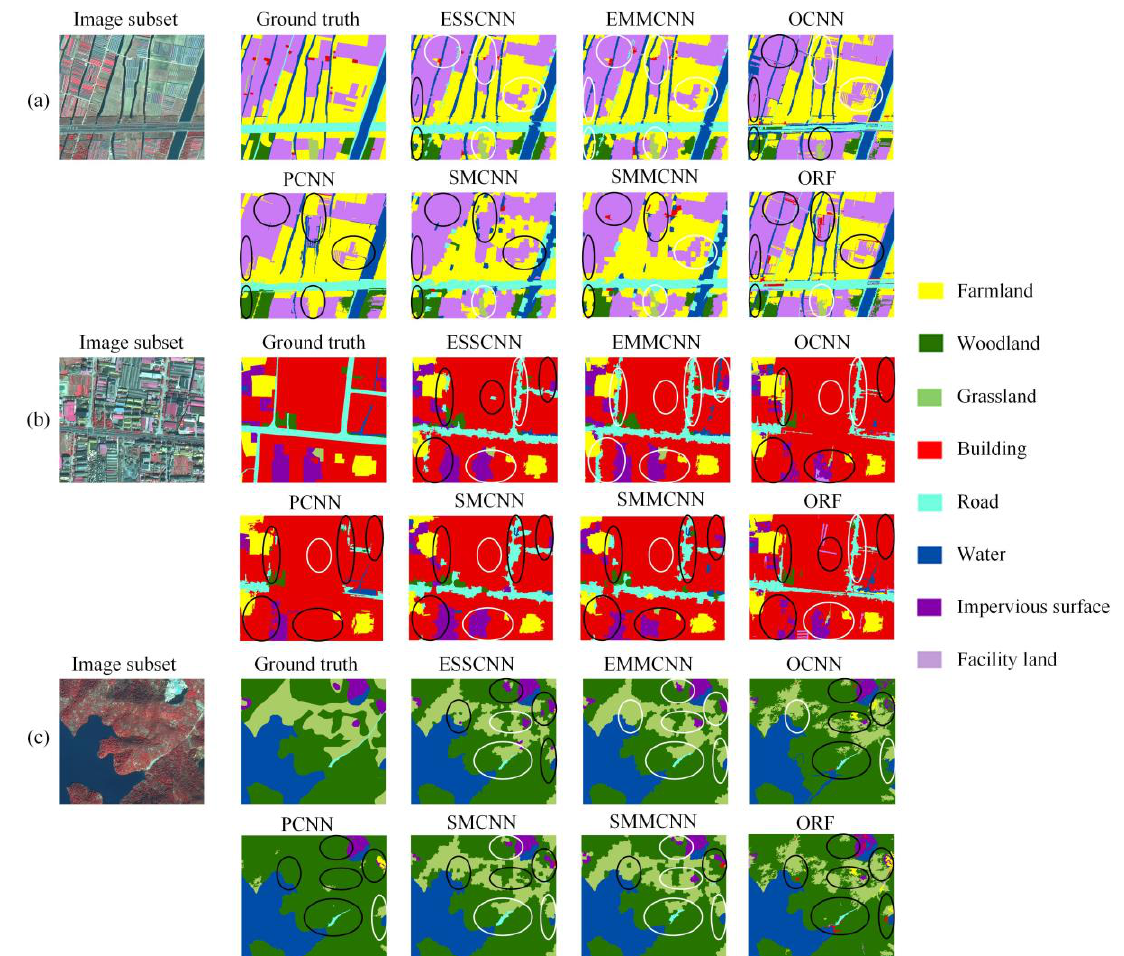
Figure 11. Three typical image subsets ( a , b , and c ) in the Cixi dataset and their classification results using ESSCNN, EMMCNN, OCNN, PCNN, SMCNN, SMMCNN, and ORF methods. The white and black circles denote the correct and incorrect classification, respectively. ESSCNN: extended topology-preserving segmentation (ETPS)-based single-scale and single-feature convolutional neural network (CNN); EMMCNN: ETPS-based multi-scale and multi-feature CNN; OCNN: object-based CNN; PCNN: patch-based CNN; SMCNN: simple linear iterative clustering (SLIC)-based multi-scale CNN; SMMCNN: SLIC-based multi-scale and multi-feature CNN; ORF: object-based random forest.